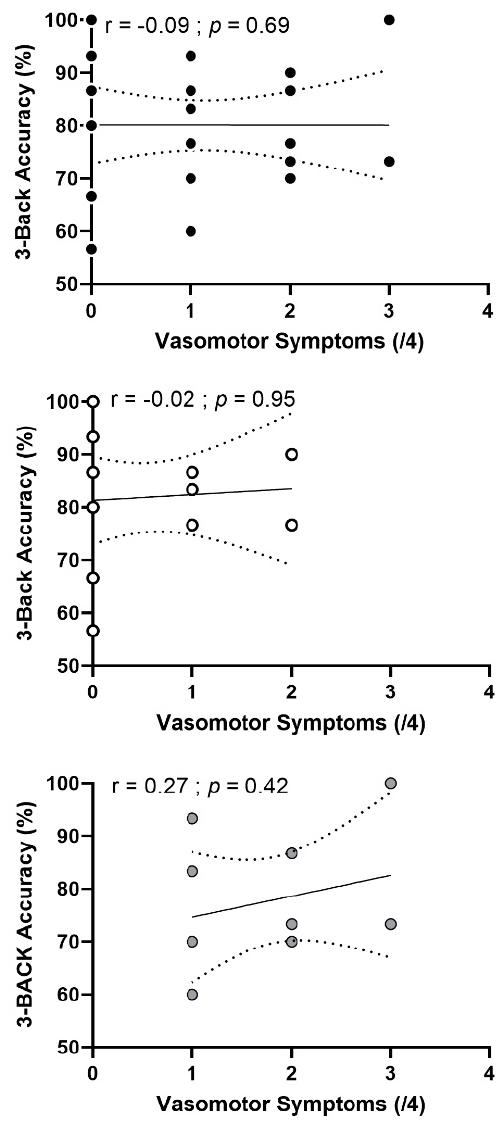
Figure 5. Relationship between accuracy in 3-Back test and vasomotor symptoms (top panels) in pre- and post-menopausal females. Top panel: pre-menopausal (n = 13) and post-menopausal (n = 10) females combined. Middle panel: pre-menopausal females only. Bottom panel: post-menopausal females only. The r and p values are for a Pearson correlation analysis.